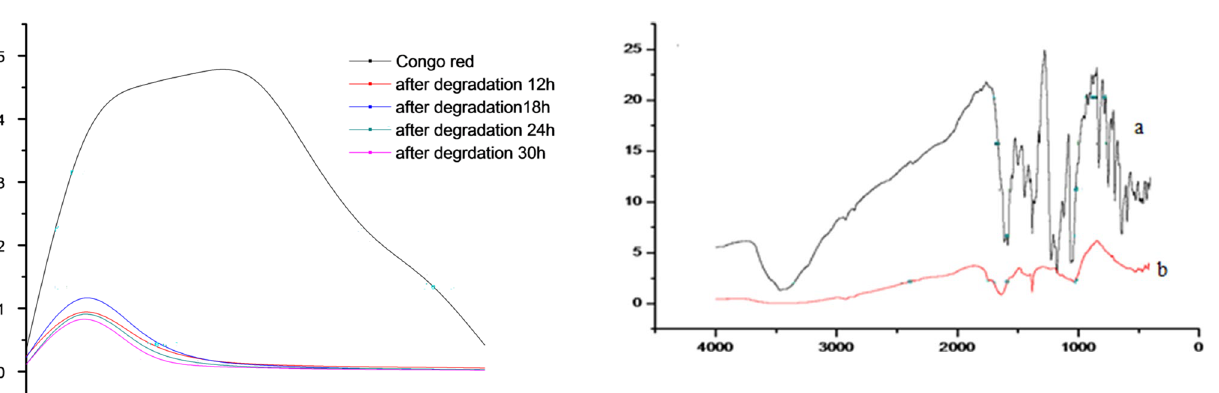
Fig. 5 Number of reusability of immobilization fungi in sodium alginate for removal dye